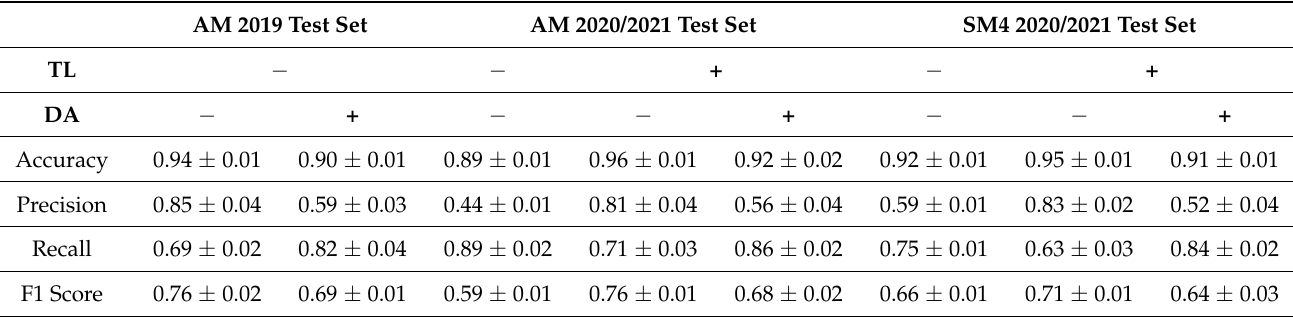
Table 1. Accuracy, precision, recall, and F1 score values were obtained for the test sets of the three sets of data (AM 2019; AM 2020/2021; and SM4 2020/2021); we obtained the uncertainty associated with the different measures through a 10-fold cross-validation. This procedure was performed alongside the transfer learning for the two 2020/2021 test sets. We also report the variation in the metrics before and after data augmentation and/or transfer learning. Specifically, we measured the metric values of AM 2019 before and after data augmentation; for both AM and SM 2020/21 we measured the metric values before and after transfer learning with or without data augmentation. TL: transfer learning; DA: data